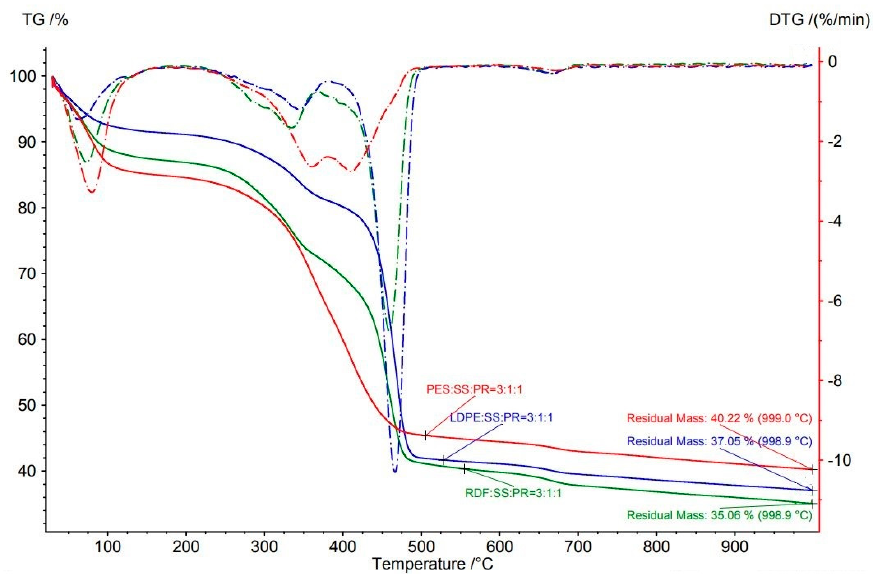
Figure 13. TG/DTG curves of RDF:SS:PR, LDPE:SS:PR and PES:SS:PR in the same volume ratios (3:1:1). Table 2. TGA/DTG results of waste blends.